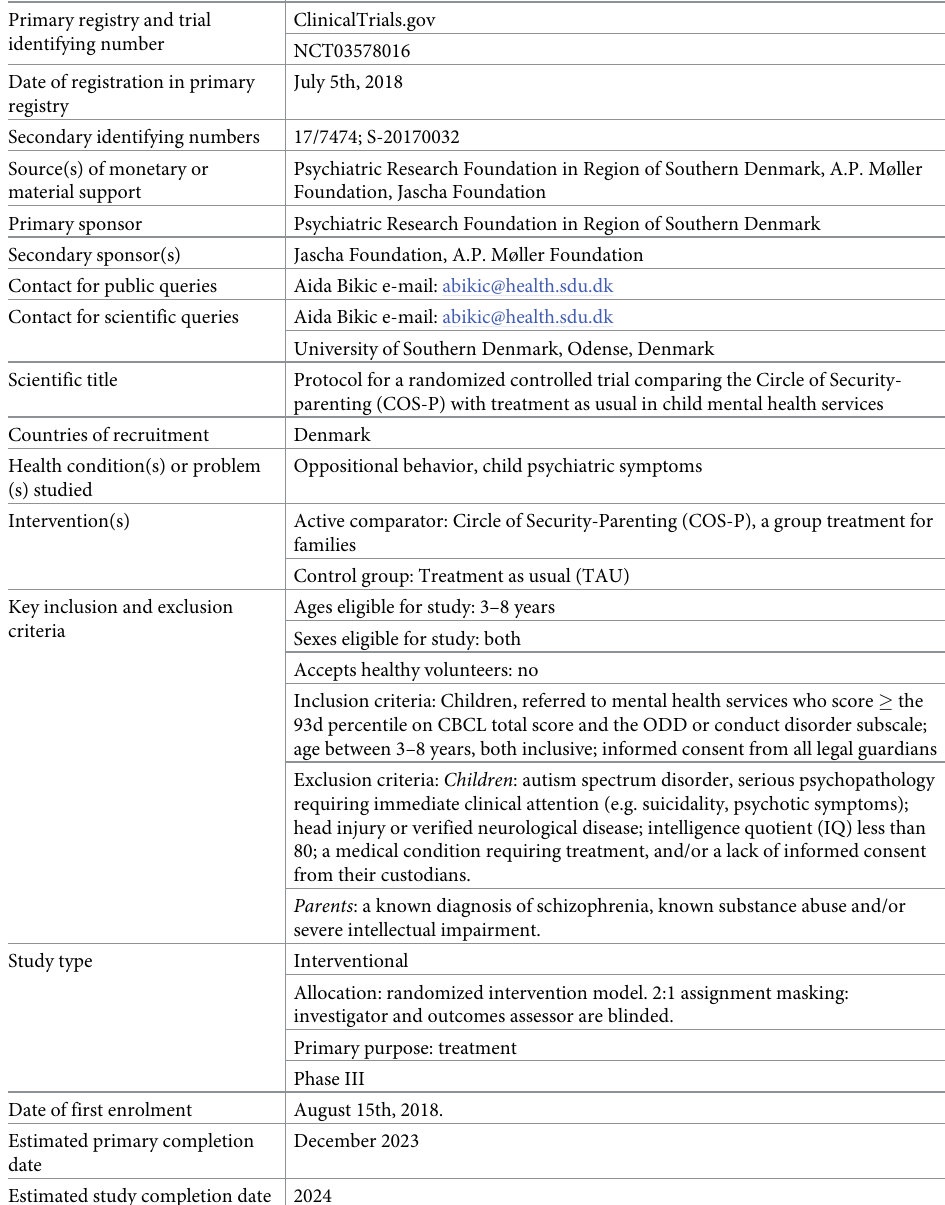
Table 1. Trial registration data